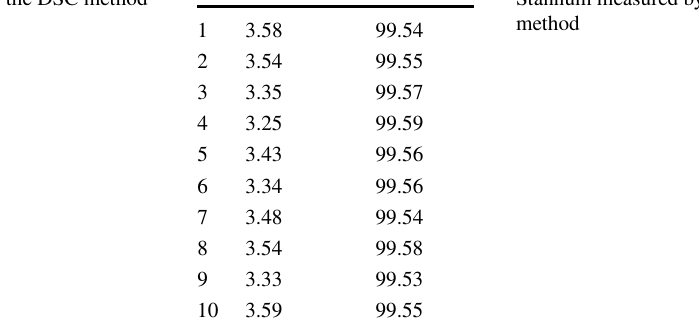
Fig. 4 The DSC curve of Betulin Table 5 Purity of analyte as determined by the DSC method